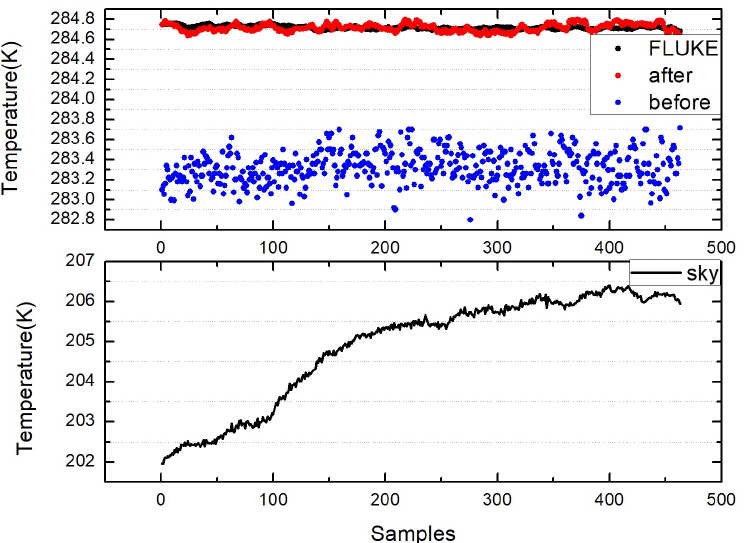
Figure 9. Measured value of the infrared thermometer on the water surface (before), the output water surface temperature value after the algorithm in this paper (after), the measured value of the water surface temperature from FLUKE (FLUKE), and the measured value of the sky from KT19